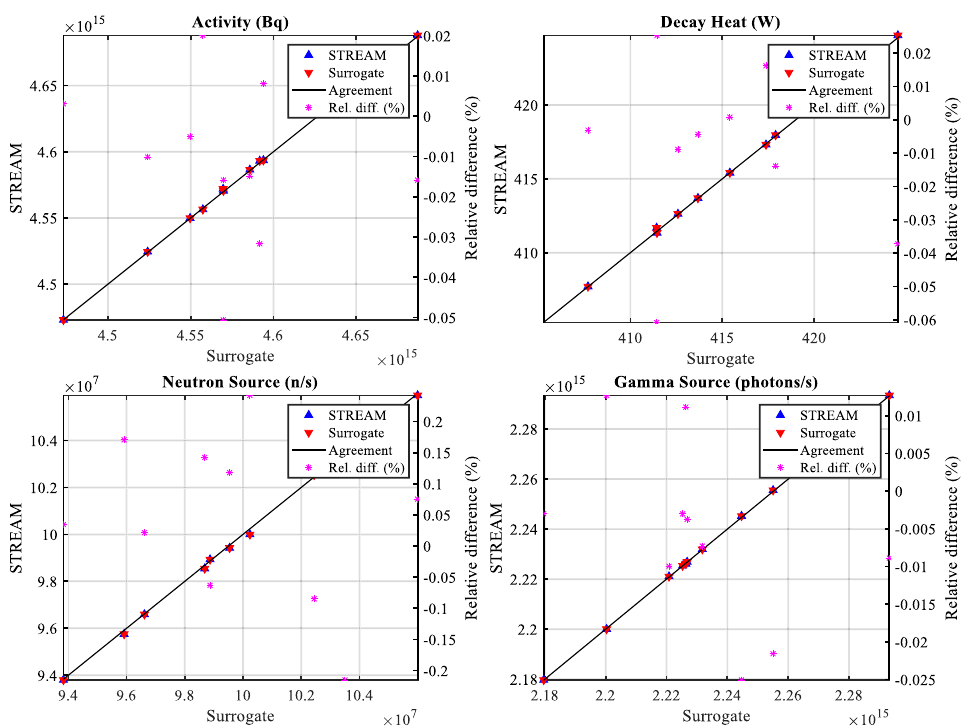
Figure 3. Comparison of source terms at 23 years from 10